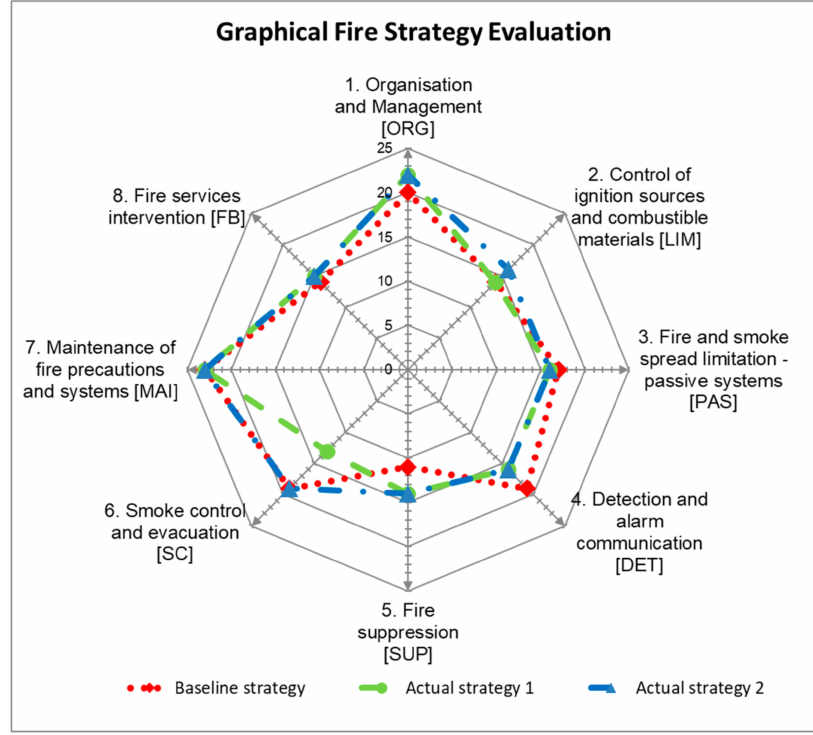
Figure 3. Fire strategy value grid for a shopping